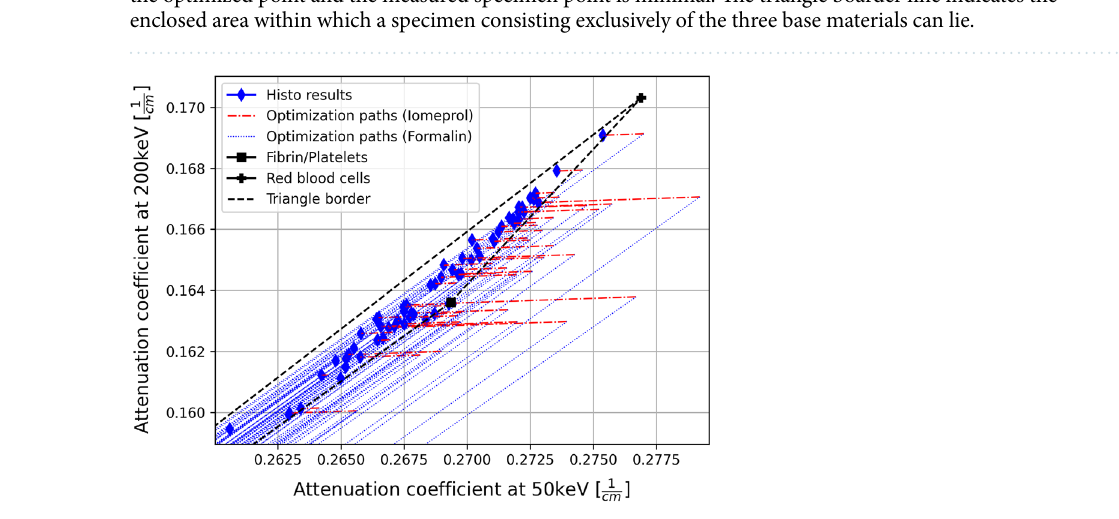
Figure 4. Illustration of the section from Fig.3c showing the iompeprol correction calculated by the algorithm. The length of the optimization paths directly correlate to the iompeprol